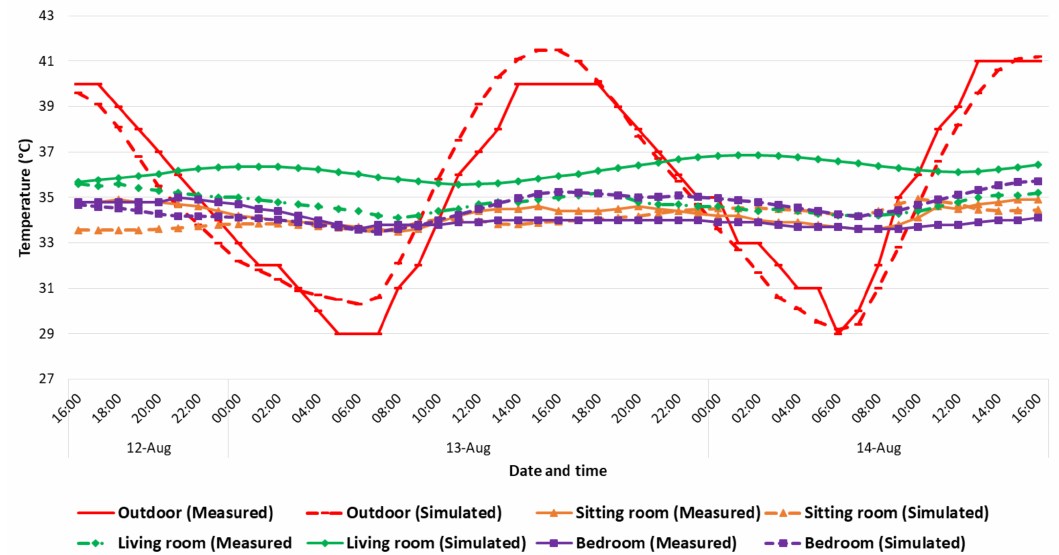
Figure 10. Outdoor and indoor air temperature corresponding to 12–14 August 2022: measured versus simulated values.